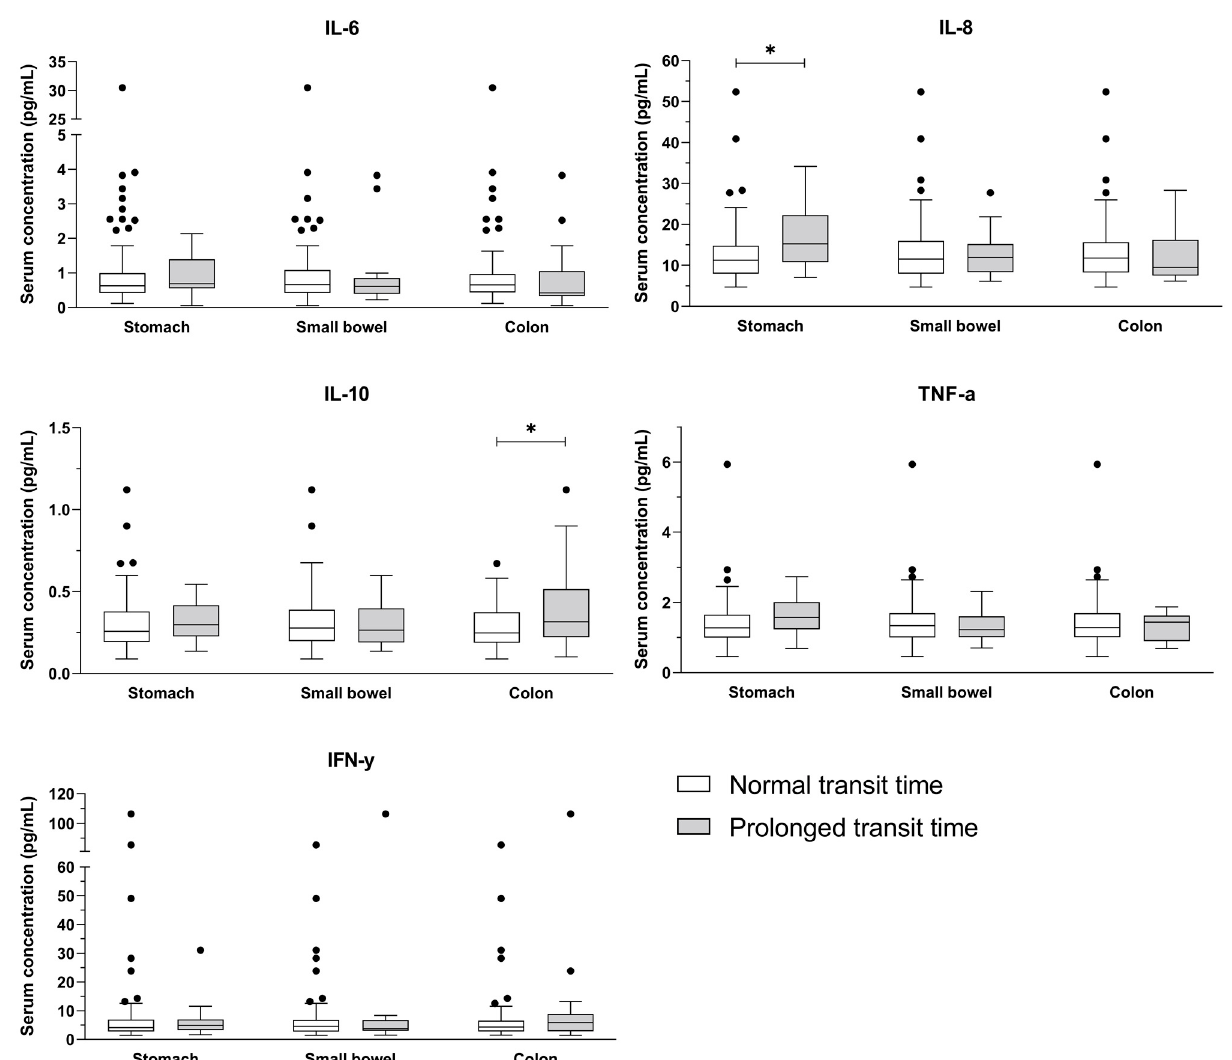
Figure 1. Serum concentrations of cytokines (IL-6, IL-8, IL-10, TNF- α , IFN- γ ) in normal and prolonged transit time of the stomach, small bowel, and colon. Outliers are seen as circles. * p < 0.05.